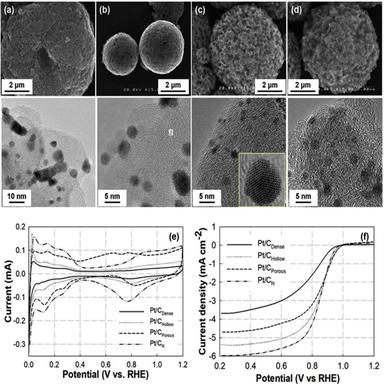
SEM (upper) and TEM (lower) images of (a) Pt/CDense, (b) Pt/CHollow reprinted (adapted) with permission from (Journal of Power Sources 2012; 203; 26–33). Copyright © 2012, Elsevier), (c) Pt/CPorous reprinted (adapted) with permission from (Fuel Cells 2012; 12; 665–669). Copyright © 2012, Wiley (& Okuyama, 2012a), and (d) Pt/CN catalysts, reprinted (adapted) with permission from (Journal of Power Sources 2013; 229; 58–64). Copyright © 2013, Elsevier), (e) CVs and (f) O